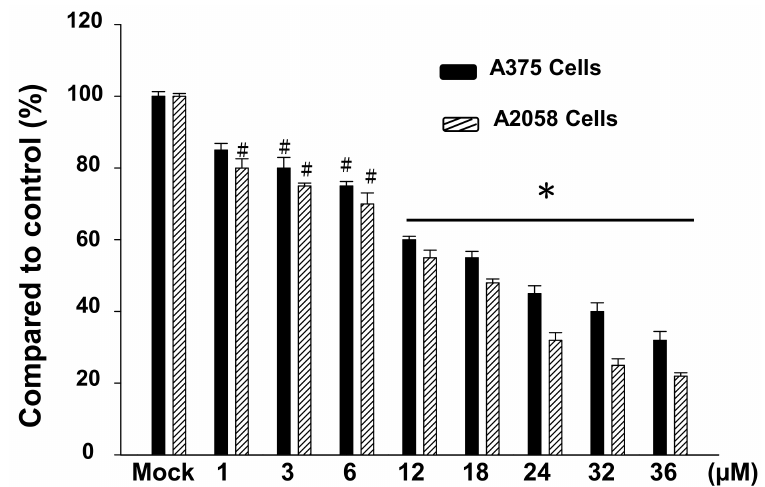
Figure 1. Cell viabilities of A2058 and A375 cells after bornyl cis -4-hydroxycinnamate treatment and vehicle control (dimethyl sulfoxide; DMSO) treatment for 24 h. A methylthiazole tetrazolium